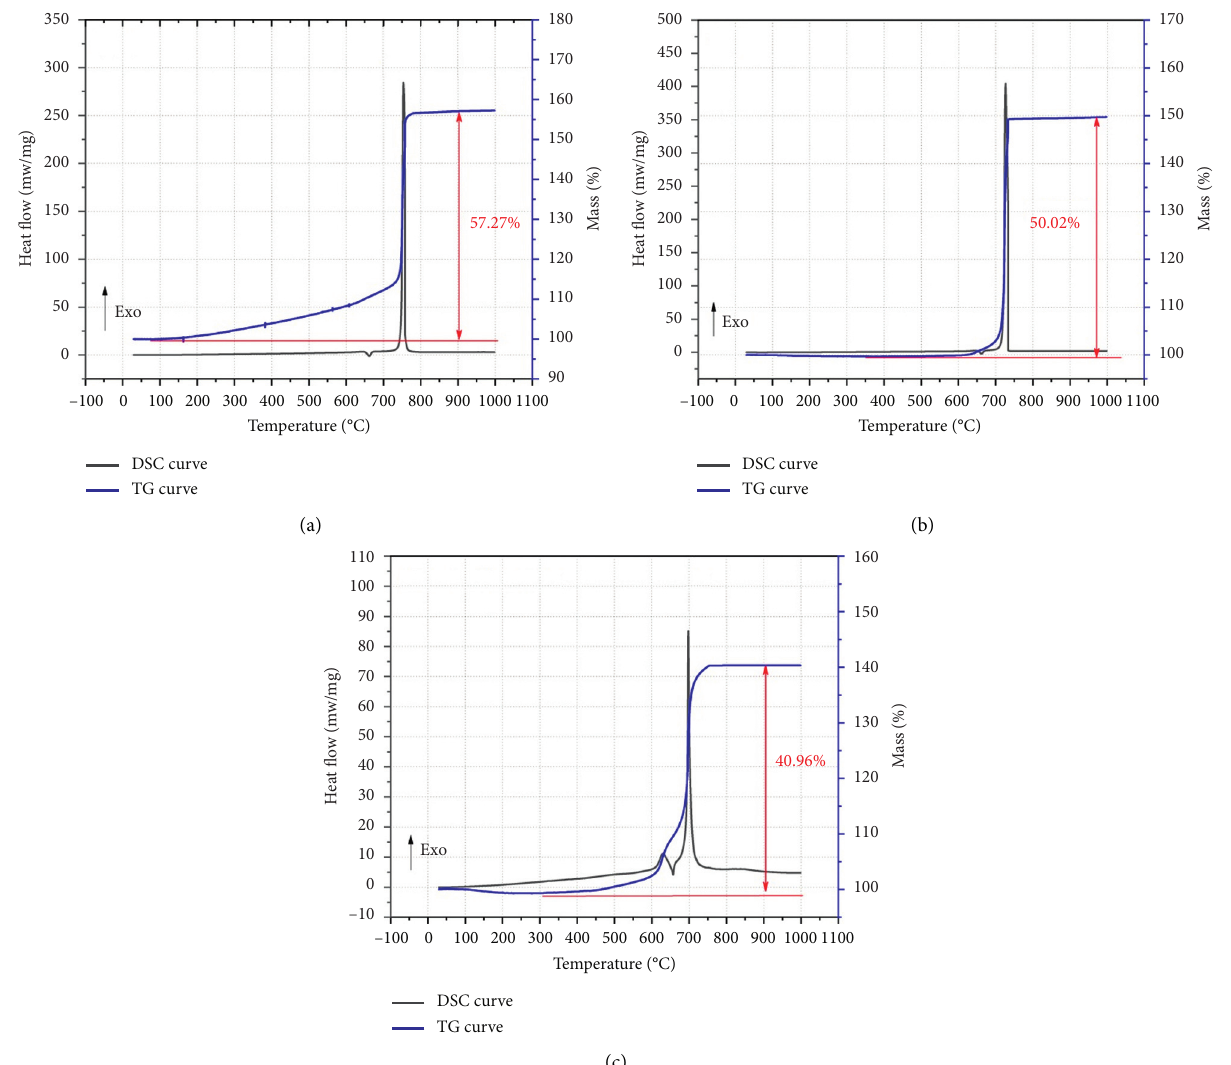
Figure 2: TG-DSC curves of different particle sizes of Al powder at air atmosphere: (a) 5 μ m Al powder, (b) 1 μ m Al powder, and (c) nano-Al